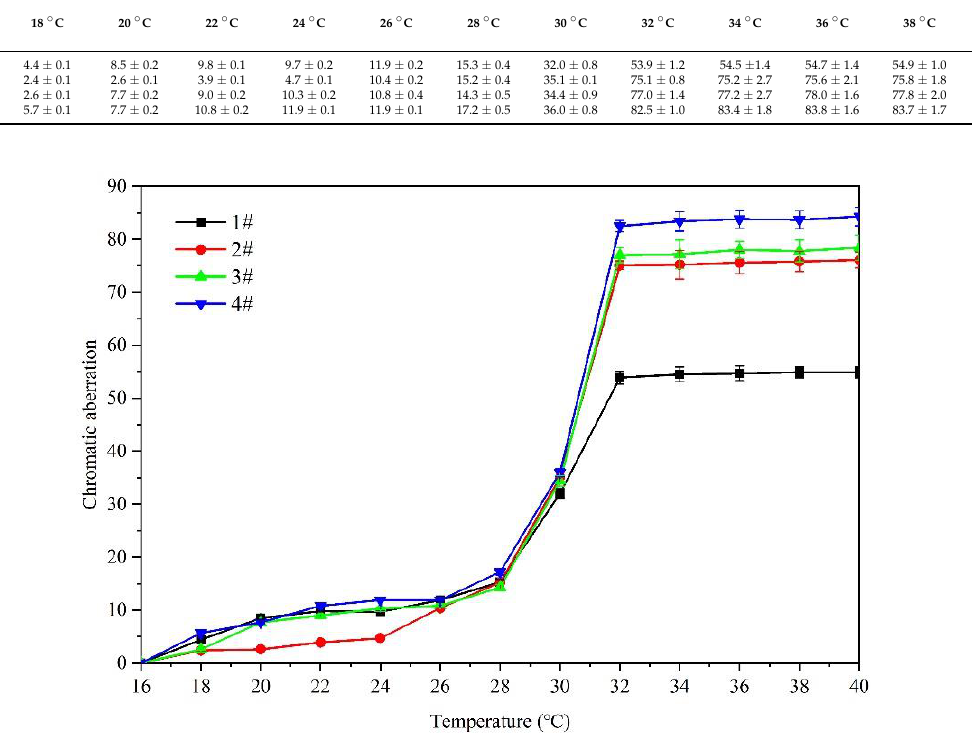
Figure 4. The temperature rise (16 °C to 40 °C) on color difference of film.